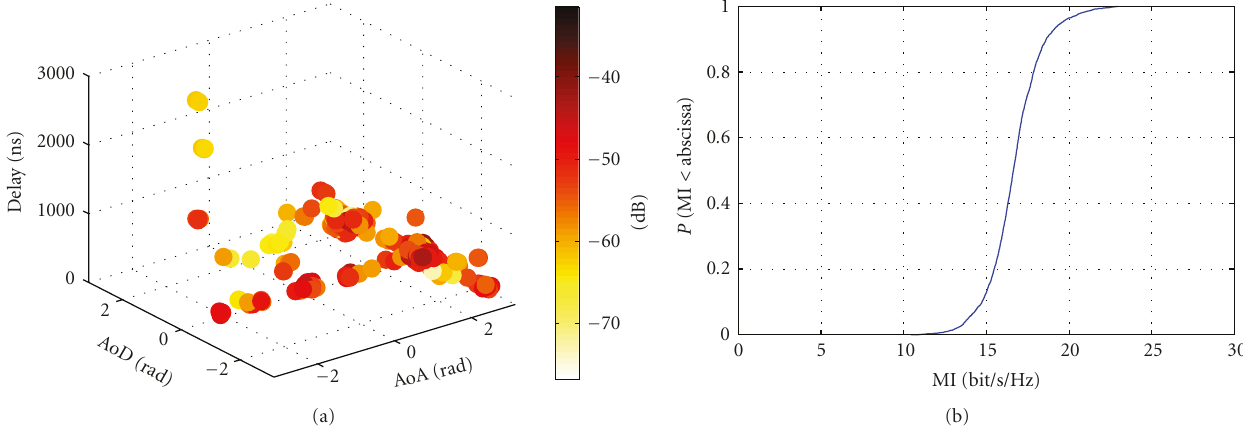
Figure 5: Why mutual information (MI) is no good validation metric: (a) multipath structure of an environment; each MPC is represented by a color-coded dot. (b) MI cdf computed from environment (a) by adding random phases to the paths, but not changing them otherwise.